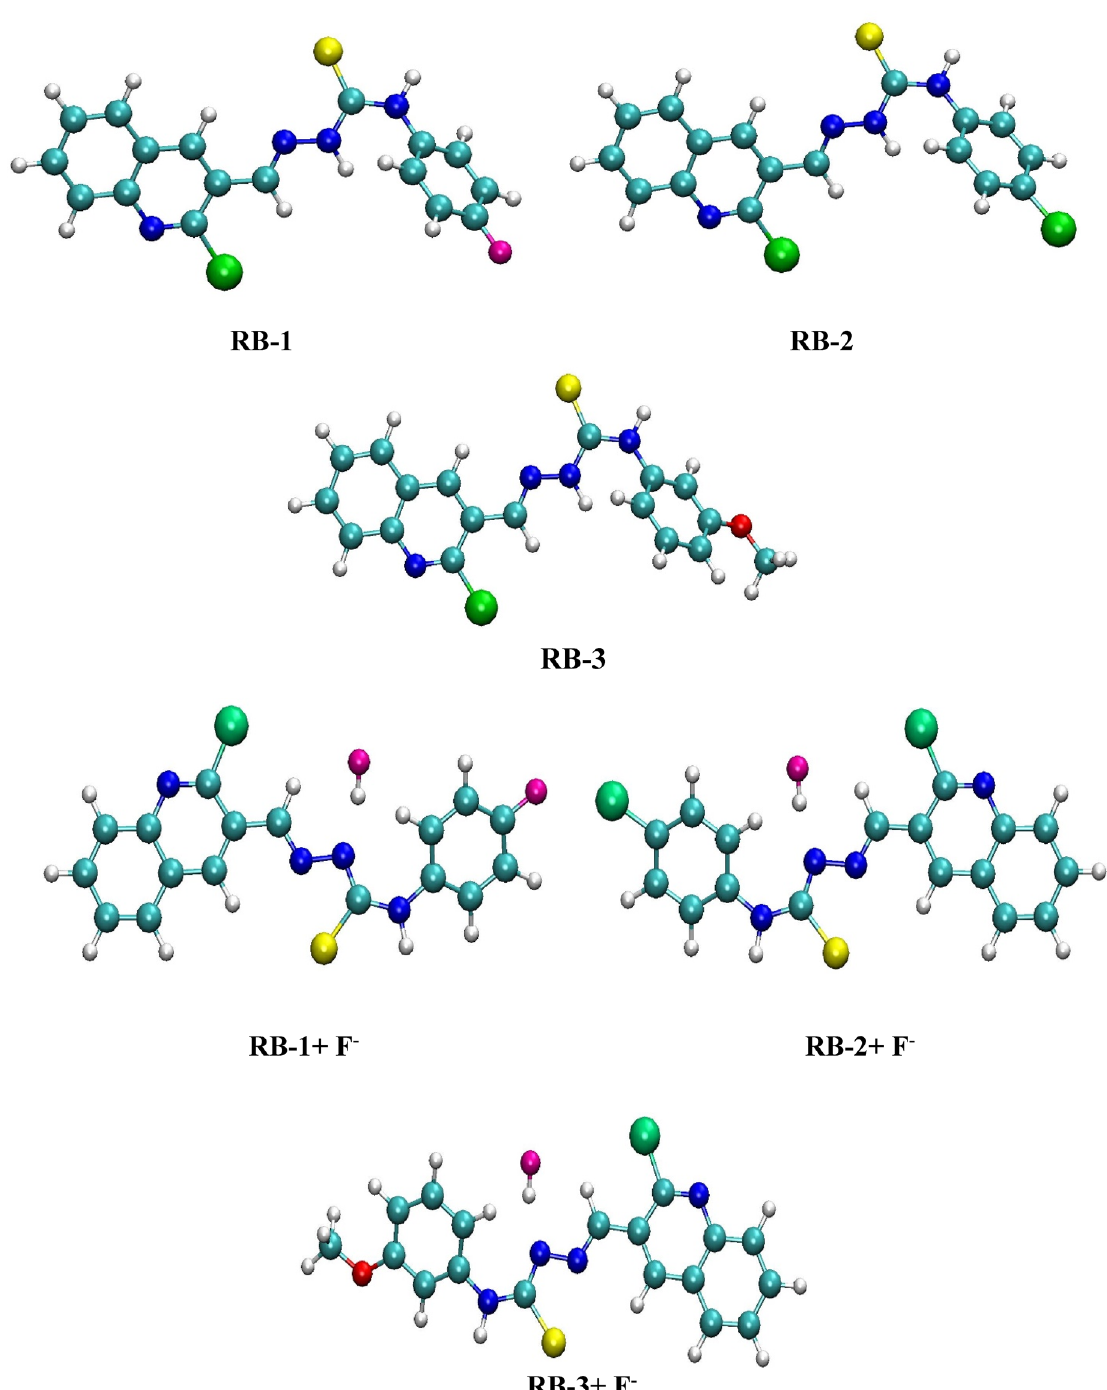
Figure 8. Optimized geometries of RB-1, RB-2 and RB-3 chemosensors without and with F − ions calculated at M06/6-311G(d,p) level of